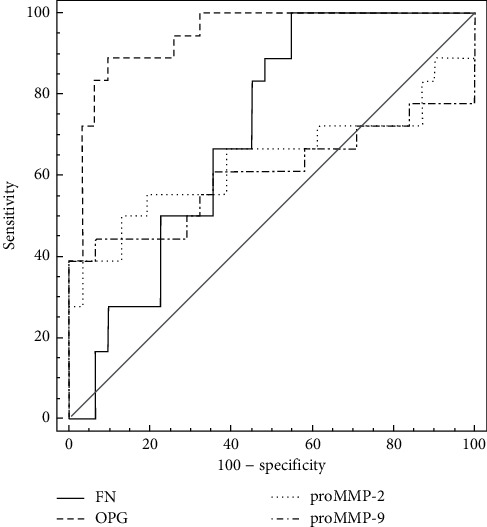
ROC curve comparison for single markers. AUC for OPG is 0.943 (P < 0.001), with associated criterion >1.0349 ng/ml; sensitivity 85.0%, specificity 92.1%. AUC for FN is 0.712 for ≤316.9966 µg/ml; sensitivity 100%, specificity 47.4%. AUC for proMMP-2 is 0.676 for activity >0.6897 AU/mg; sensitivity 55.0%, specificity 87.5%. AUC for proMMP-9 is 0.625, with associated criterion >0.2637 AU/mg, sensitivity 42.1%, and specificity 100.0%.